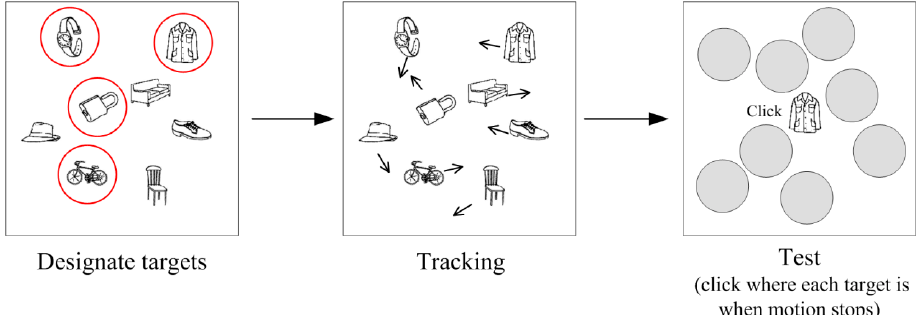
Figure 2. In the multiple identity tracking (MIT) task, all objects have distinct identities; in this example they are line drawings of common objects. In the initial target designation stage, the targets to be tracked are shown, for example, by drawing a red circle around them. Then all objects move for a few seconds. In the test phase, all objects stop moving and the targets are probed, for example, one by one by asking the participant to locate where each target was positioned at the time the movement was terminated.